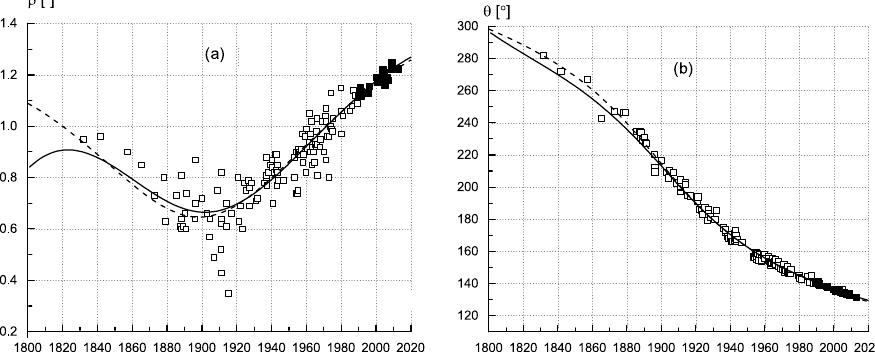
Fig. 3. HIP 15058. Same notations as in Fig. 2. The solid curves (cid:12)t the AMP orbit of this study, the dashed curves (cid:12)t the orbit of Riddle et al.